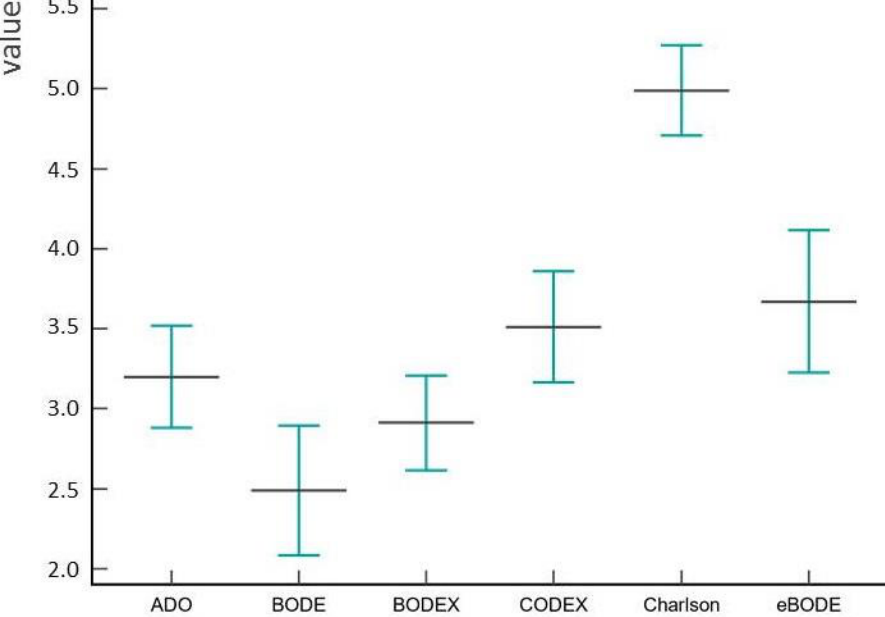
Figure 3. Diagram of the index values at the second control point.